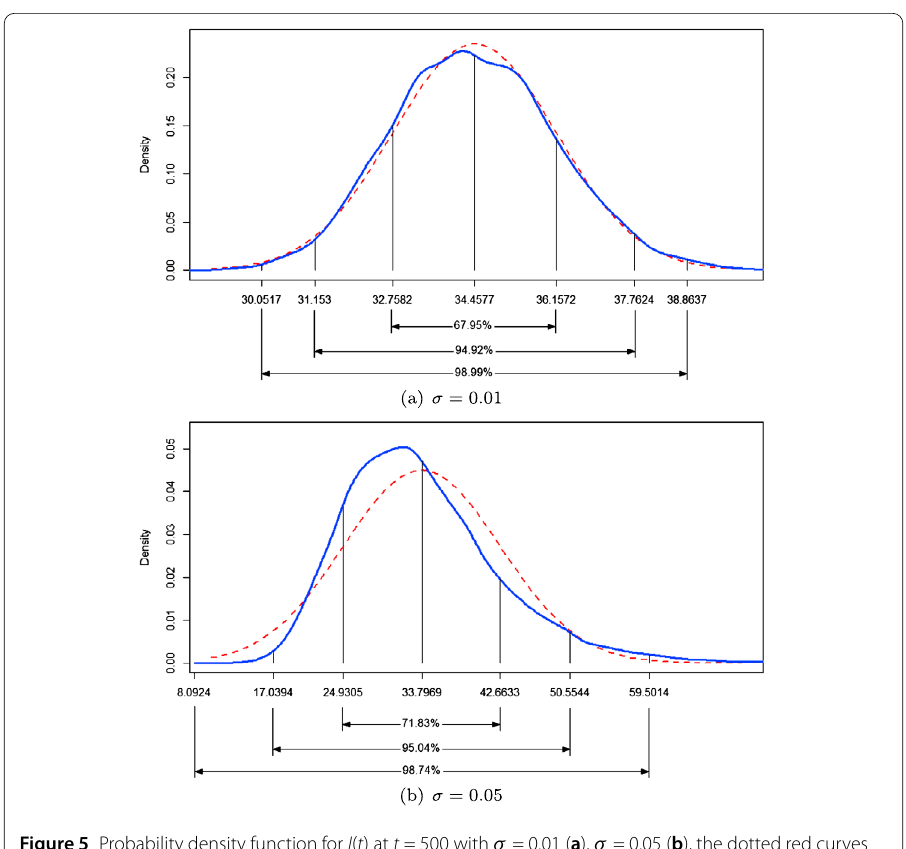
Figure 5 Probability density function for I ( t ) at t = 500 with σ = 0.01 ( a ), σ = 0.05 ( b ), the dotted red curves are the normal distributions N (34.4577,1.6995 2 ) ( a ) and N (33.7969,8.8664 2 ) ( b ), respectively. Other parameters are taken as (19)